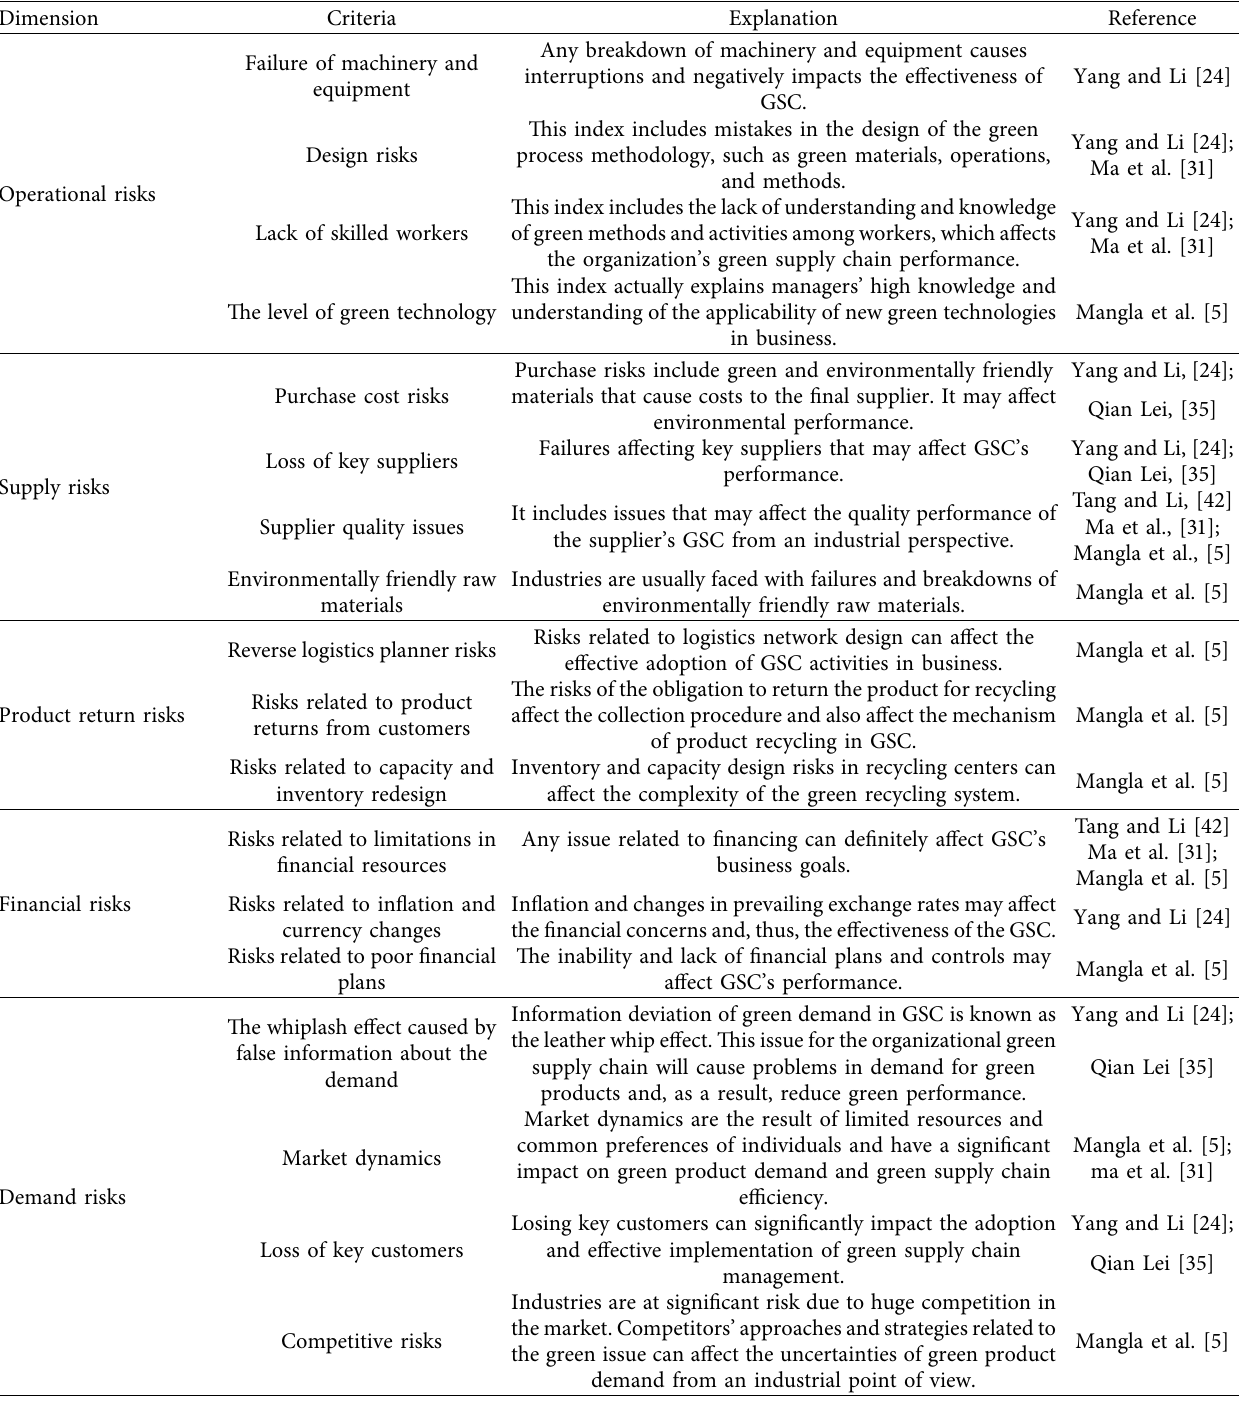
Table 1: Summary of the reviewed